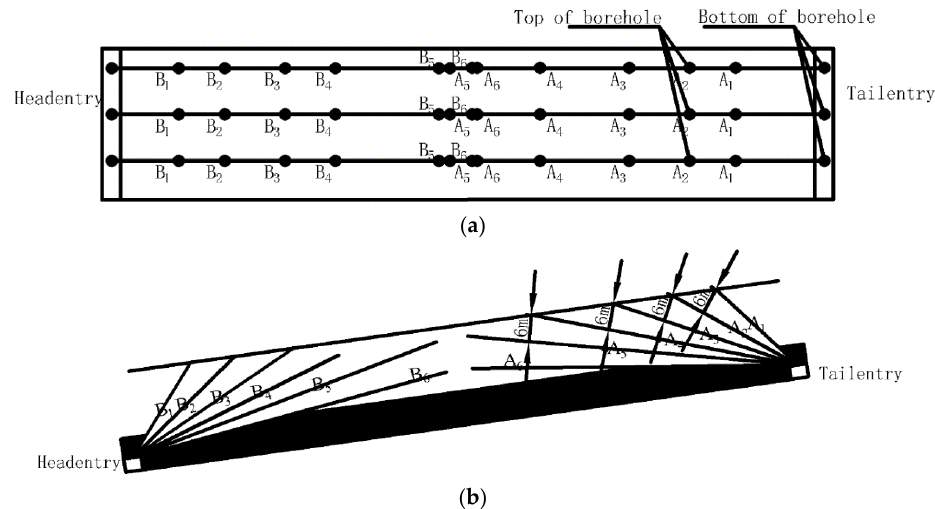
Figure 6. Distributions of boreholes in the roof for directional pre-splitting blasting at ( a ) horizontal position, ( b ) vertical position.